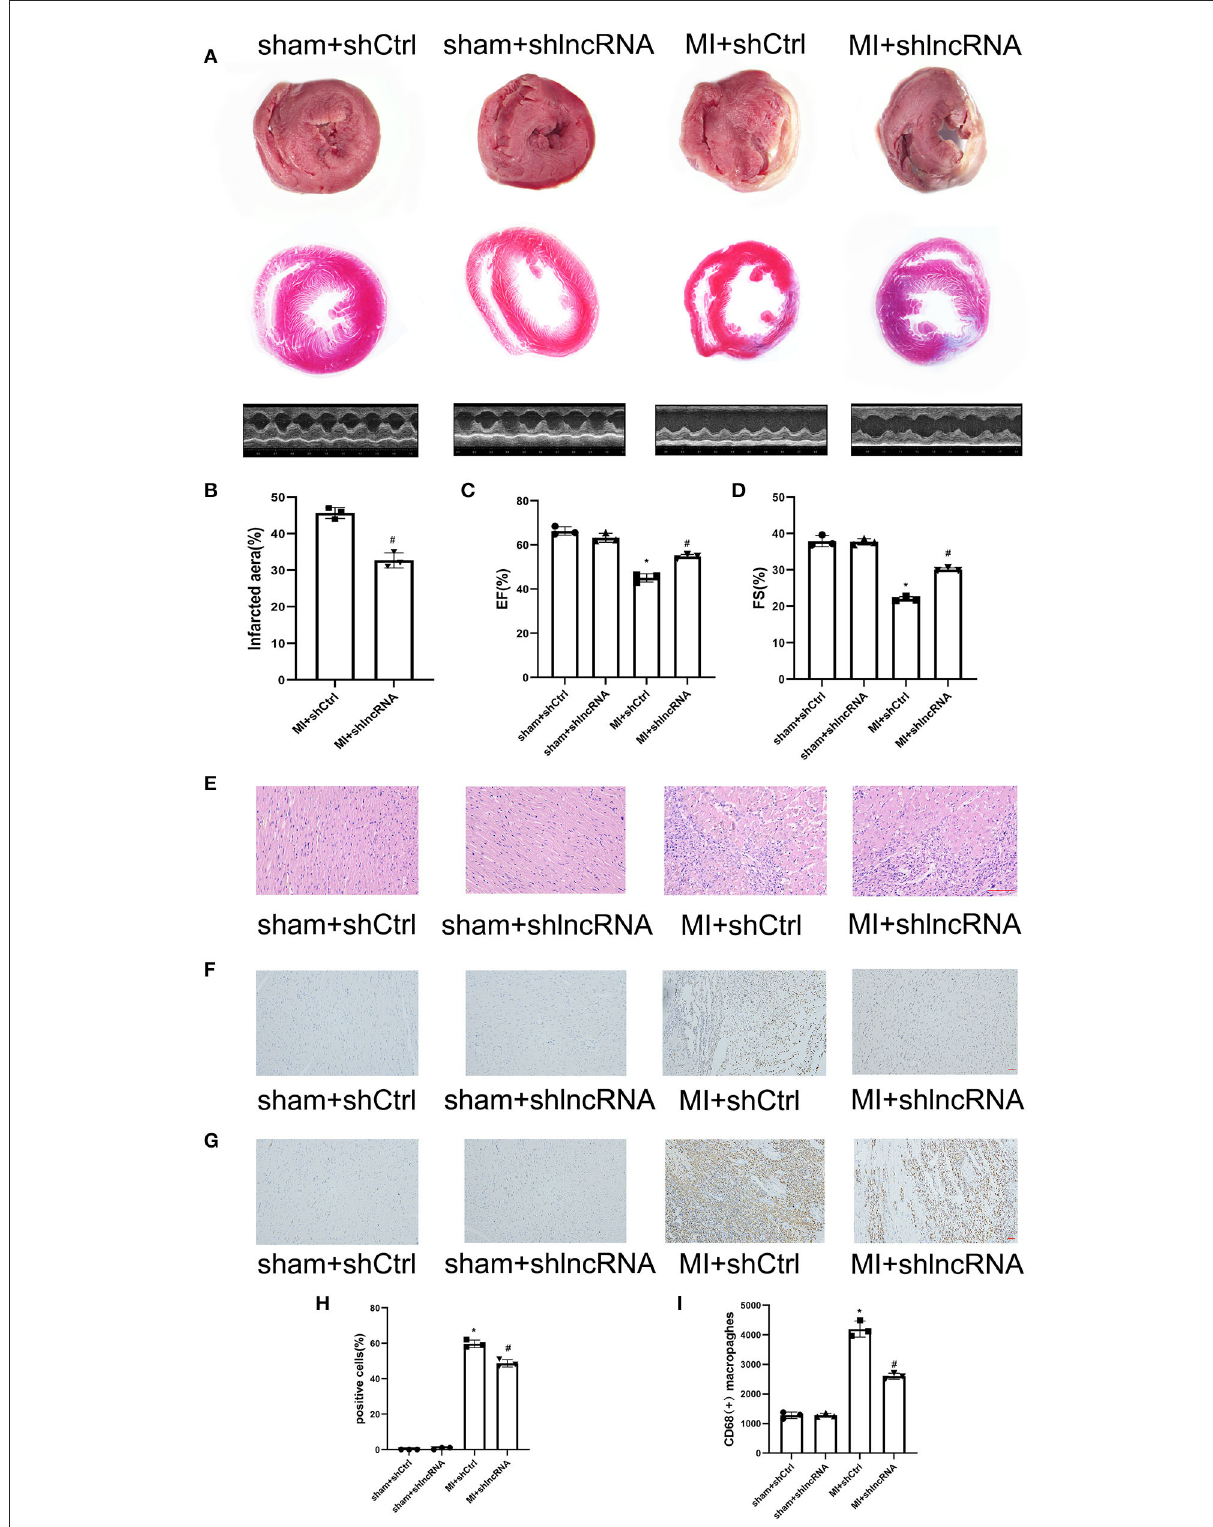
FIGURE7 lncRNA LOC100911717 silencing improves cardiac function post-MI. (A) TTC staining, Masson staining, and parasternal long axis view of M-type echo of rat heart in the sham + shCtrl, sham + shlncRNA, MI + shCtrl, and MI + shlncRNA groups. (B) Comparisons of the infarcted area in the MI + shCtrl and MI + shlncRNA groups, n = 3 per group. (C, D) Comparisons of the left ventricular EF and left ventricular FS between the four groups,